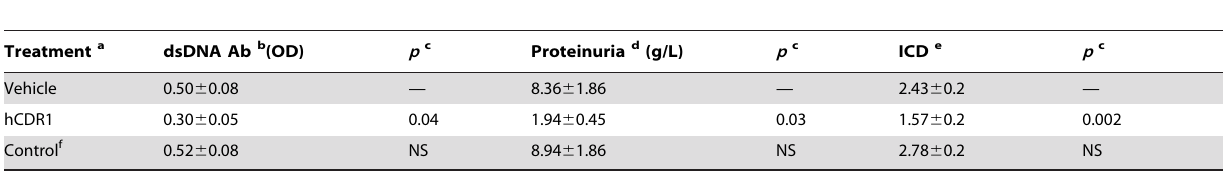
Table 1. Effects of treatment with hCDR1 on SLE manifestations in mice.